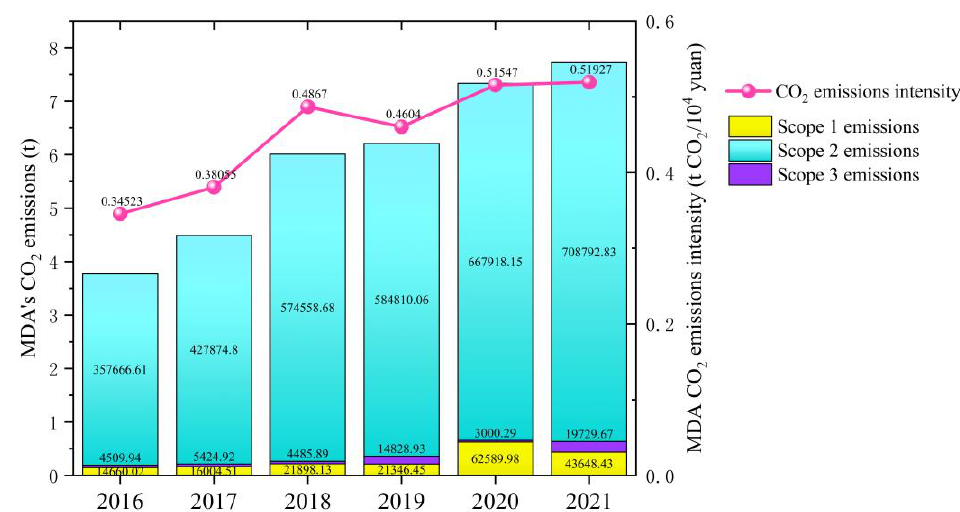
Figure 3. Total emissions and emissions intensity from 2016 to 2021.